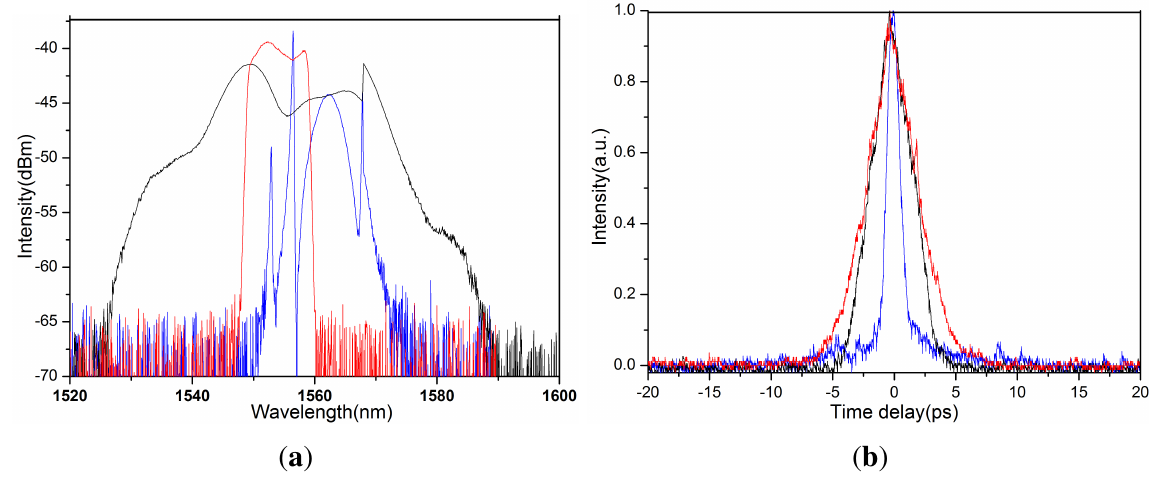
Figure 7. Typical ( a ) measured optical spectra and ( b ) autocorrelation traces for the output soliton (blue), dispersion-managed (DM) soliton (black) and dissipative soliton (DS) (red). Adapted from